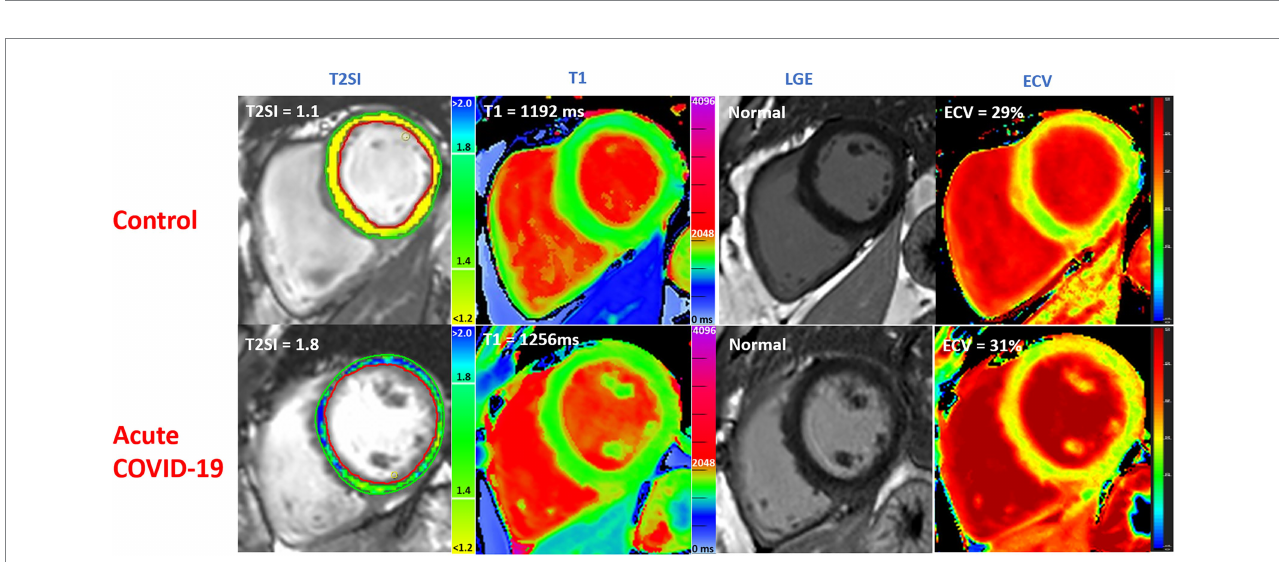
FIGURE 4 Multiparametric CMR imaging in 3 T MRI scanner comparing acute COVID-19 patients during their hospitalization with matched controls without COVID-19 from the community. T2SI = T2 signal intensity ratio (myocardium: skeletal muscle). LGE, late gadolinium enhancement; ECV, extra cellular volume fraction. Normal values: T1 ≤ 1,244 ms, T2 ≤ 1.4. All values correspond to single slice have been